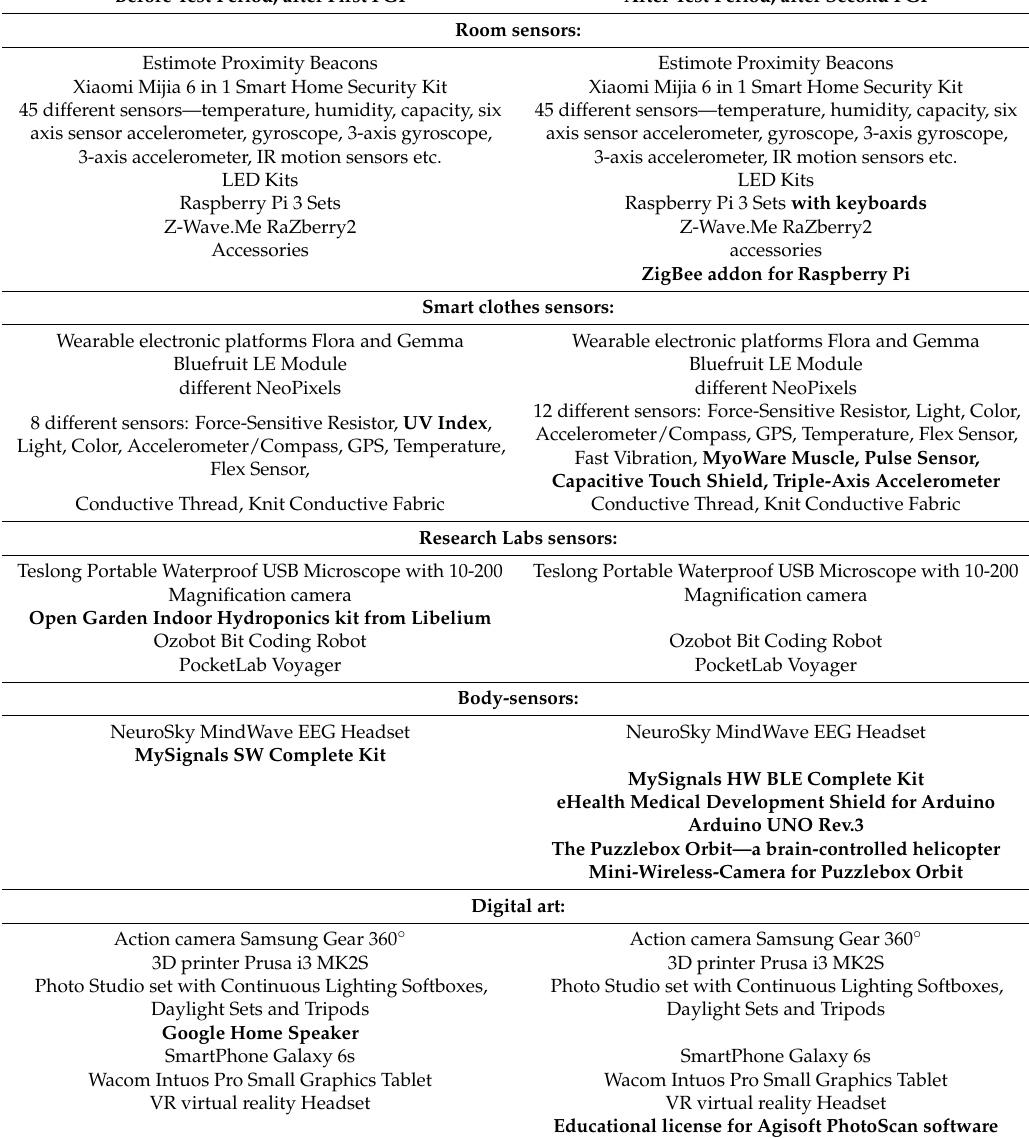
Table 3. The list of IoT kits based on the interviews with the focus groups. Before Test Period, after First FGI After Test Period, after Second FGI Room